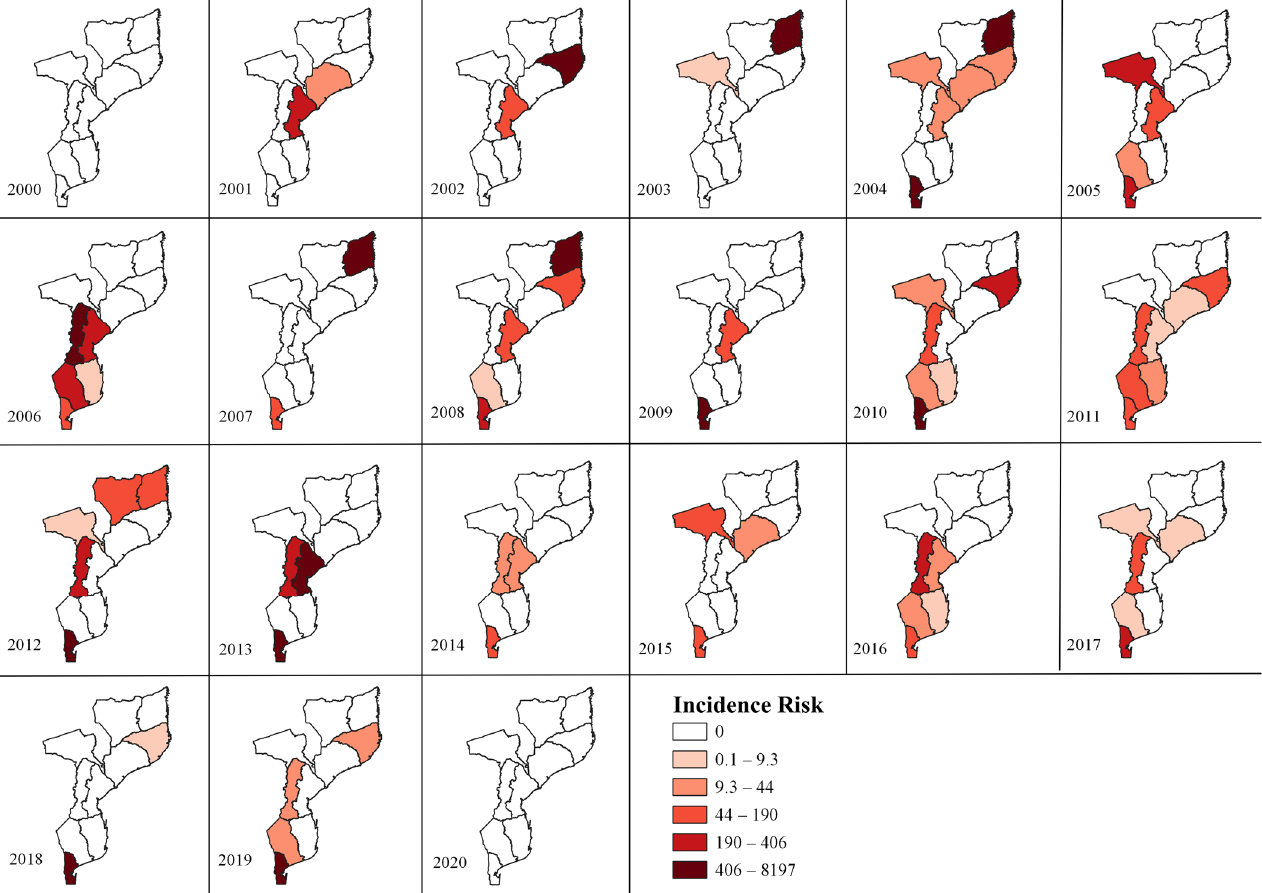
Figure 3. Spatial distribution of incidence risk (IR) of African swine fever per 100,000 pigs between the years 2000 to 2020 in the provinces of Mozambique. Note: In 2020, the IR was 190.78 in Maputo City. However, due to the size of the regions associated with the scale of the map, it is not possible to visualize the color scale.